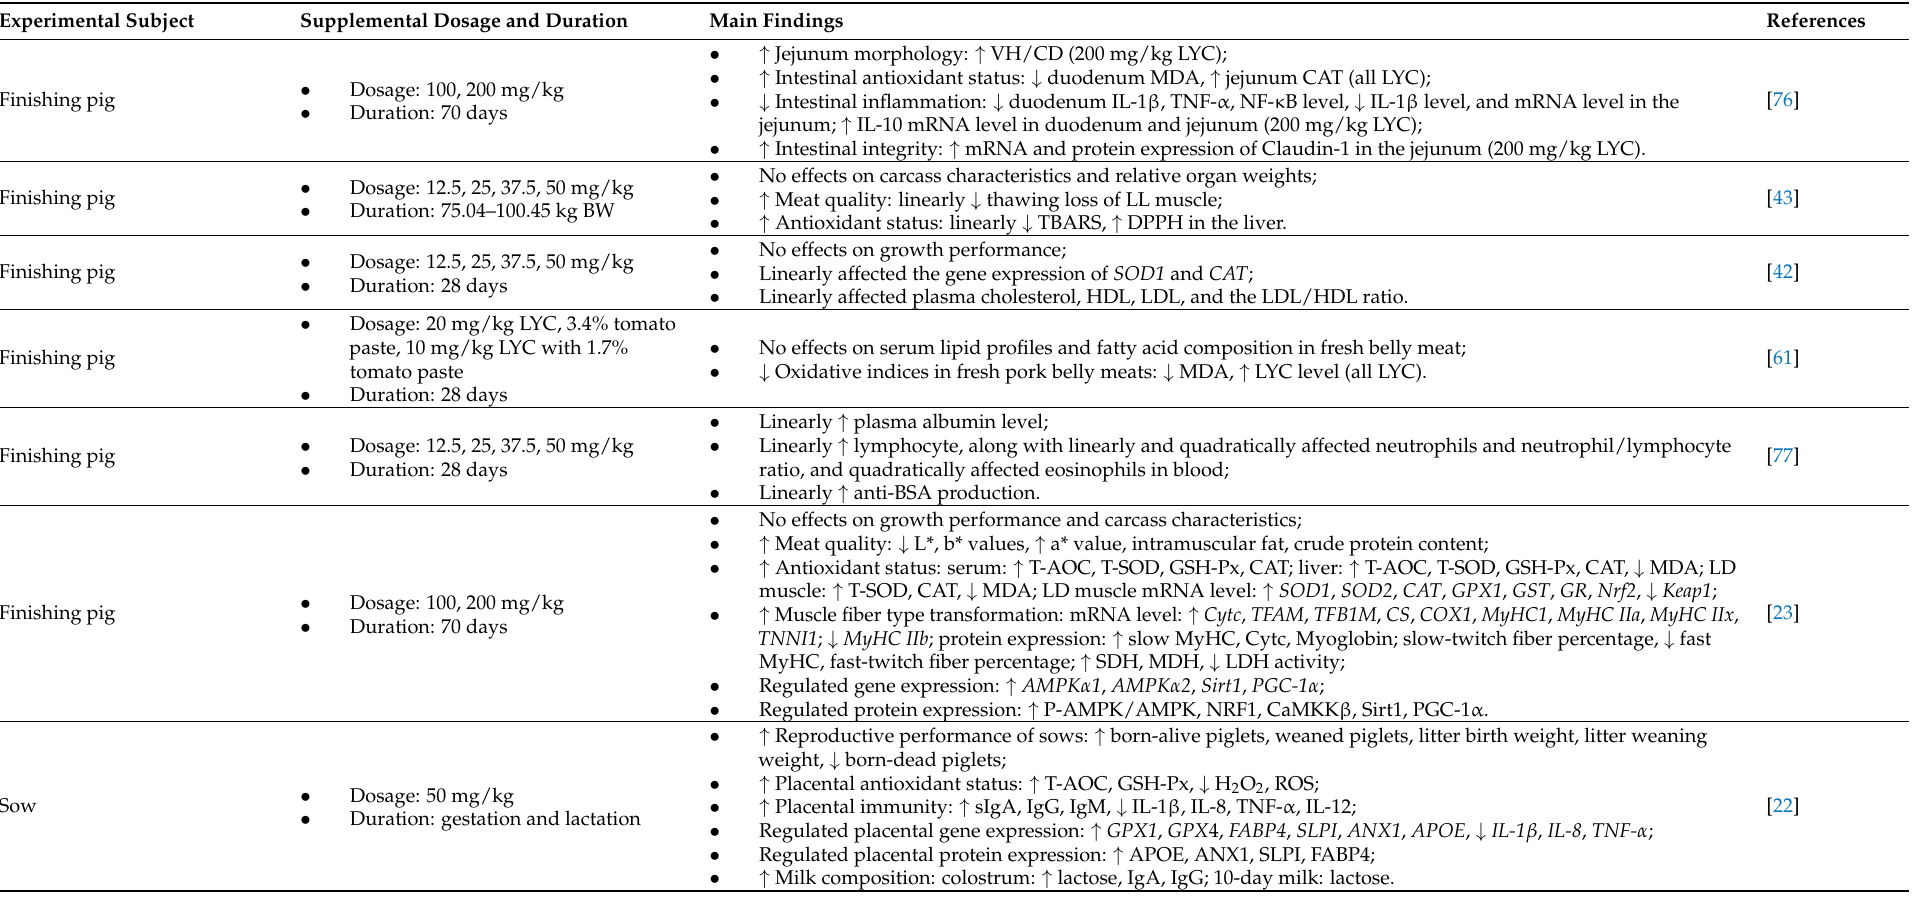
Table 1. The summary of lycopene (LYC) as a functional feed additive for swine during the past decade